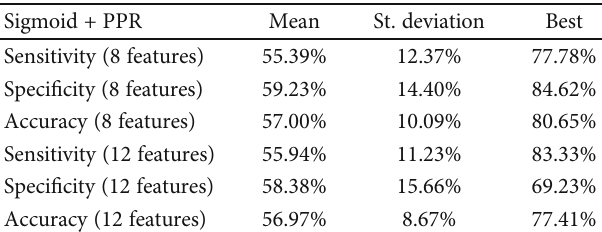
Table 14: Results of SVM with a sigmoid kernel and posterior probability regions.